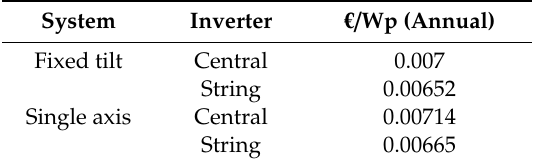
Table A4. Fixed tilt and Single-axis tracking operation and maintenance